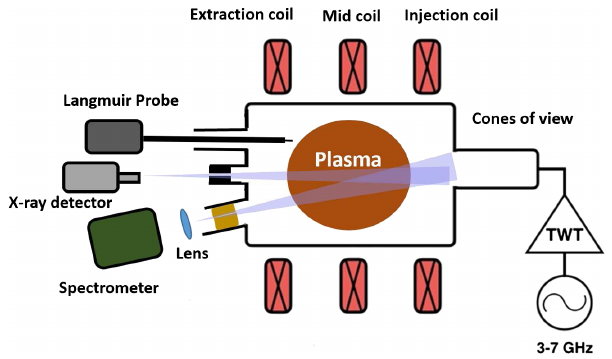
FIG. 1. Sketch of the FPT setup including the arrangement of the diagnostics.